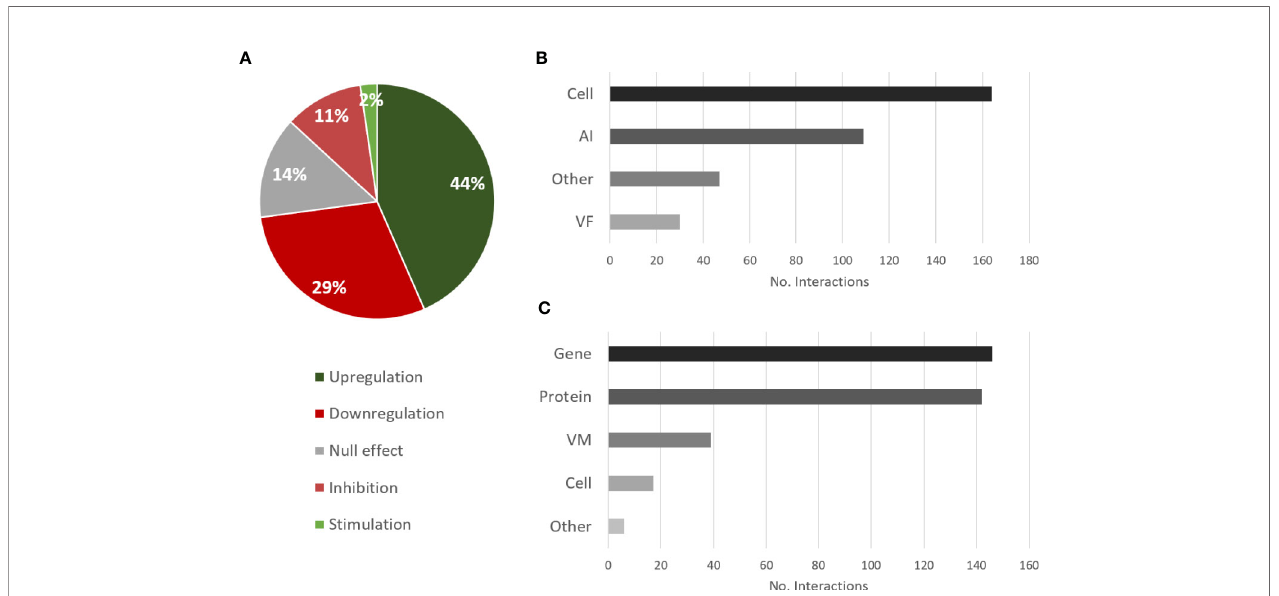
FIGURE 3 | Overview of the types of interactions and entities annotated for the effects of P. aeruginosa on C. albicans . (A) Proportional data on the types of interactions; (B) Total number of interactions annotated for each source category; (C) Total number of interactions annotated for each target category.